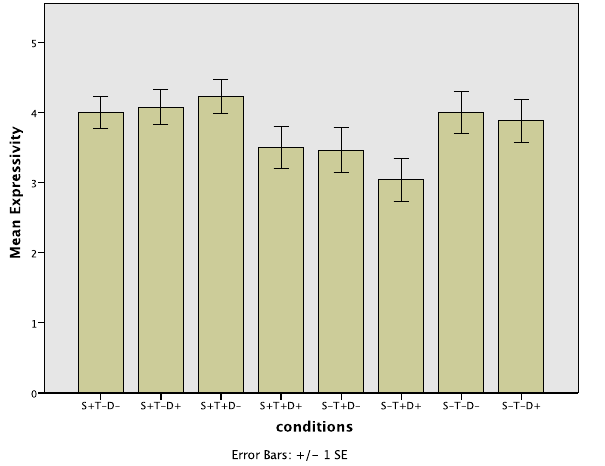
Figure 6: Average scores of cohesion for the different conditions of spatial synchronicity (S+/S-), temporal synchronicity (T+/T-), and inter-robot distance